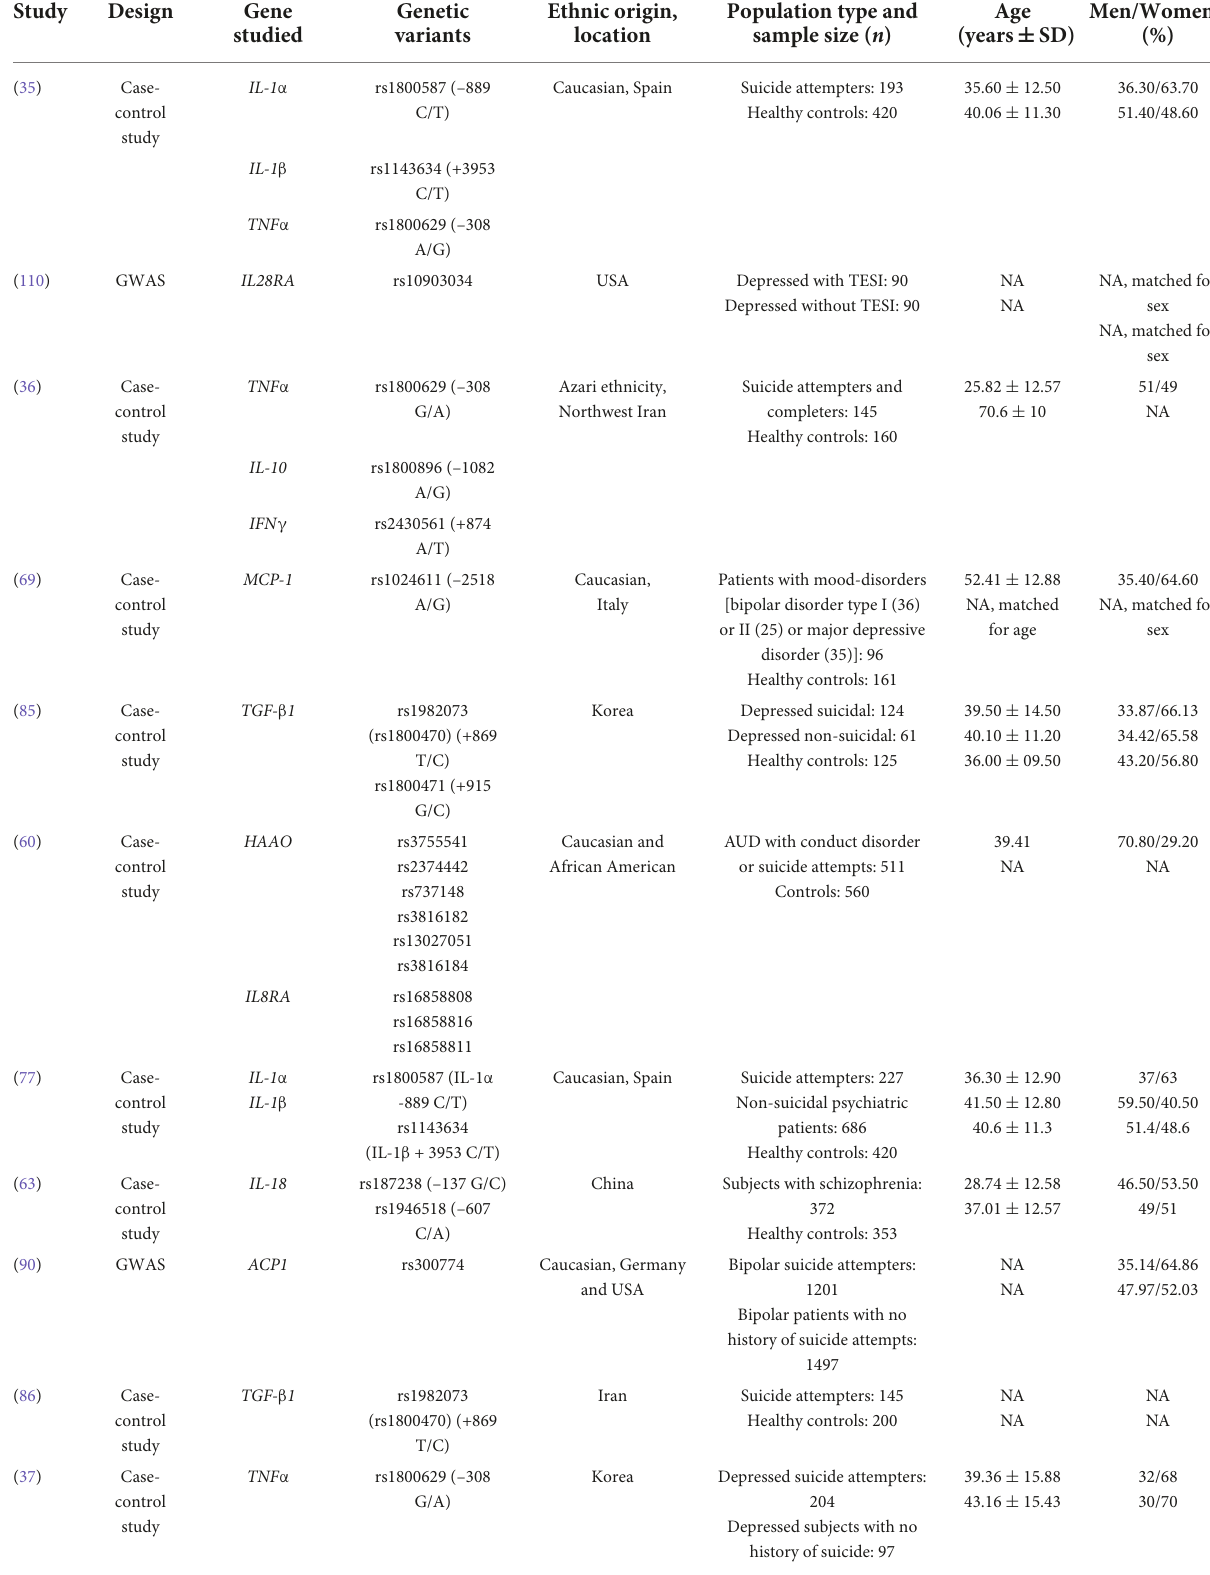
TABLE 1 Description of the studies included in the